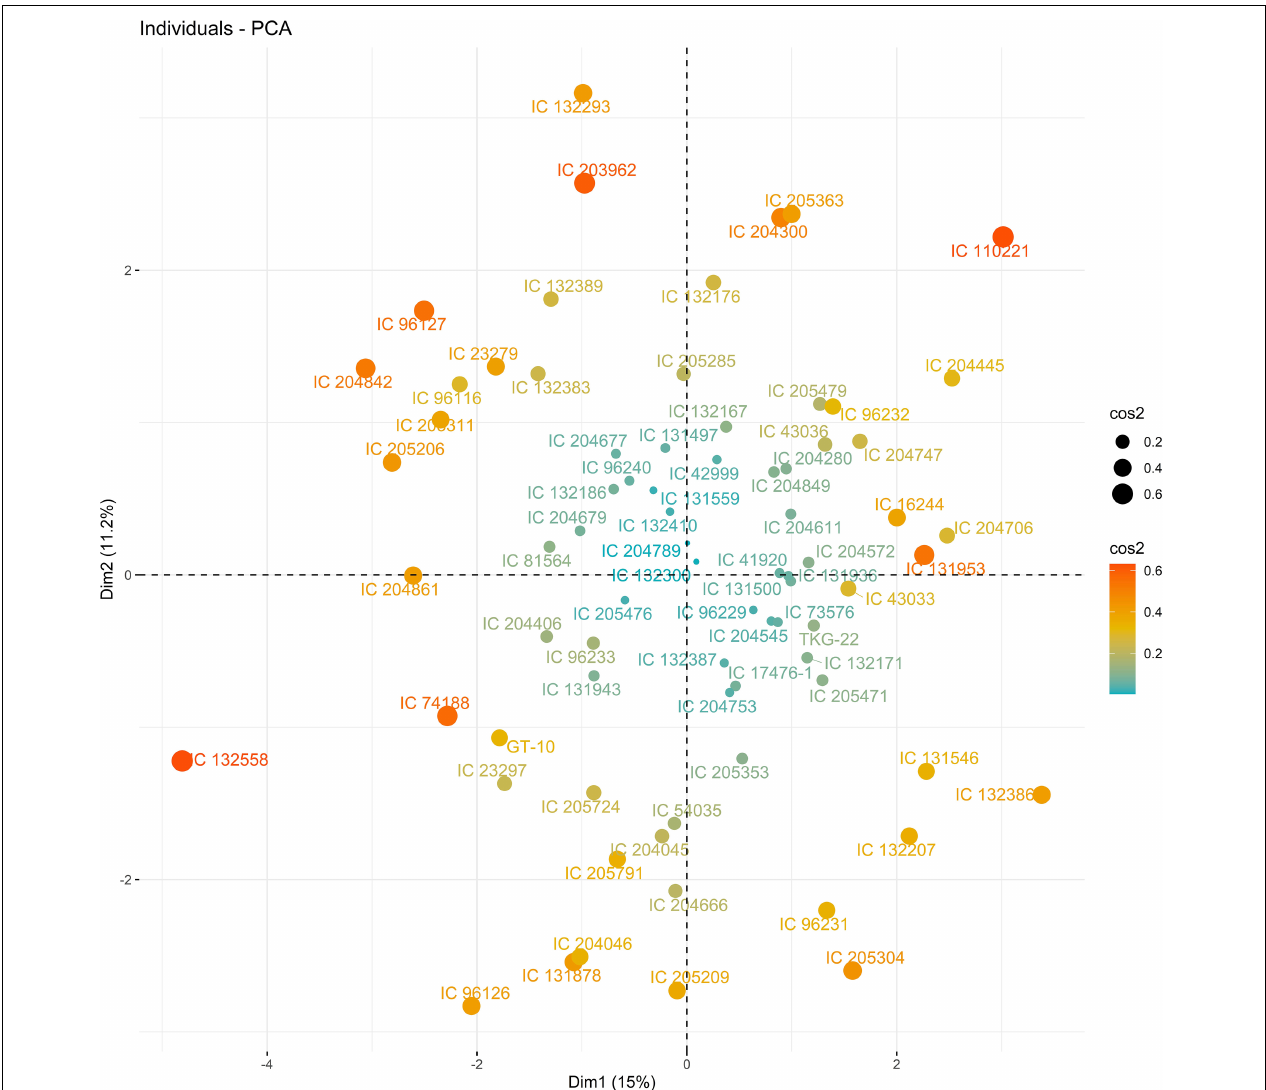
FIGURE 8 | Principal scatter plot of the first two principal component analysis (PCA) of 76 sesame genotypes during year 2019 under WS conditions.